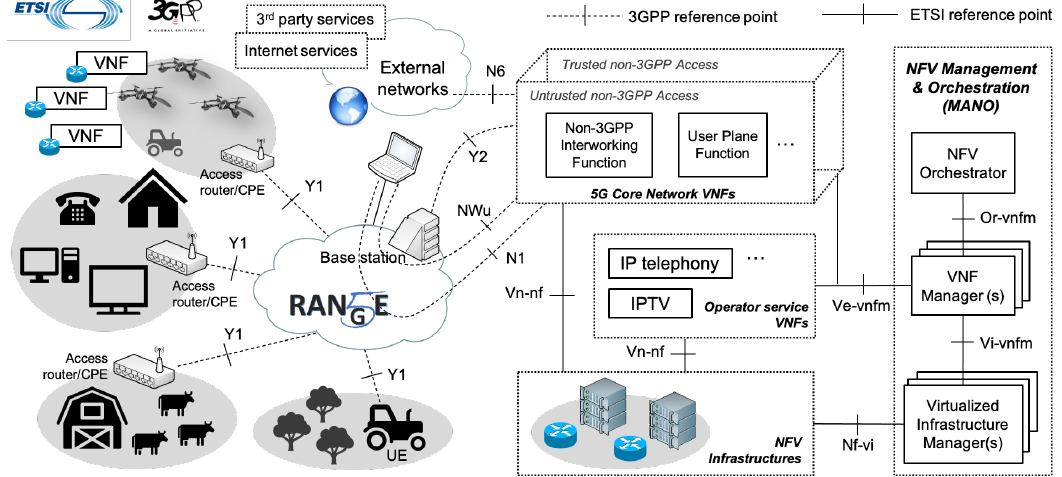
Figure 2. High-level overview of the 5G-RANGE